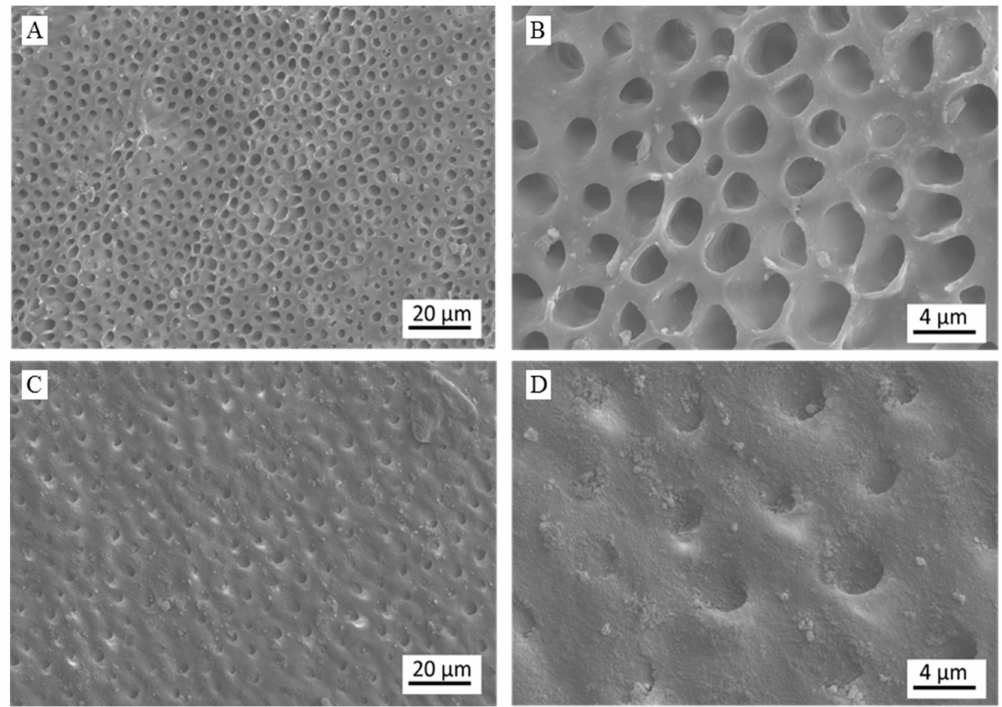
Figure 6. Representative FEG-SEM micrographs of demineralized dentine treated with ( A , B ) only water and ( C , D ) the toothpaste (below) at magnification levels of ( A , C ) 2500 × and ( B , D ) 10,000 ×